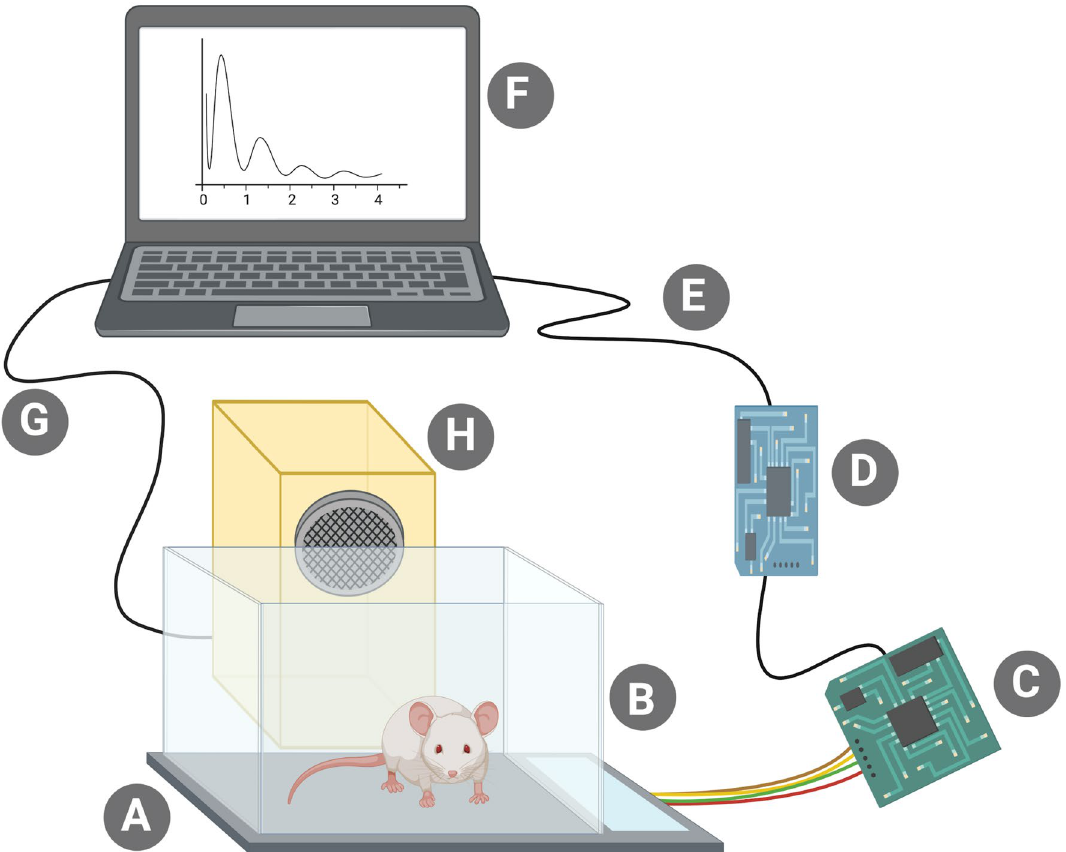
Figure 1. A schematic display of Platform for Acoustic STArtle (PASTA). ( A ) The key ingredient of PASTA—a modified kitchen scale. ( B ) A clean mouse cage affixed on top of the kitchen scale. ( C ) A readily-available controller circuit board based on the HX711 integrated circuit ( D ) A communication board, NodeMCU ESP-32S ( E ) USB cable ( F ) Your fancy laptop with our fancy Python script ( G ) A normal audio cable. Really, there is nothing special about it. ( H ) Standard